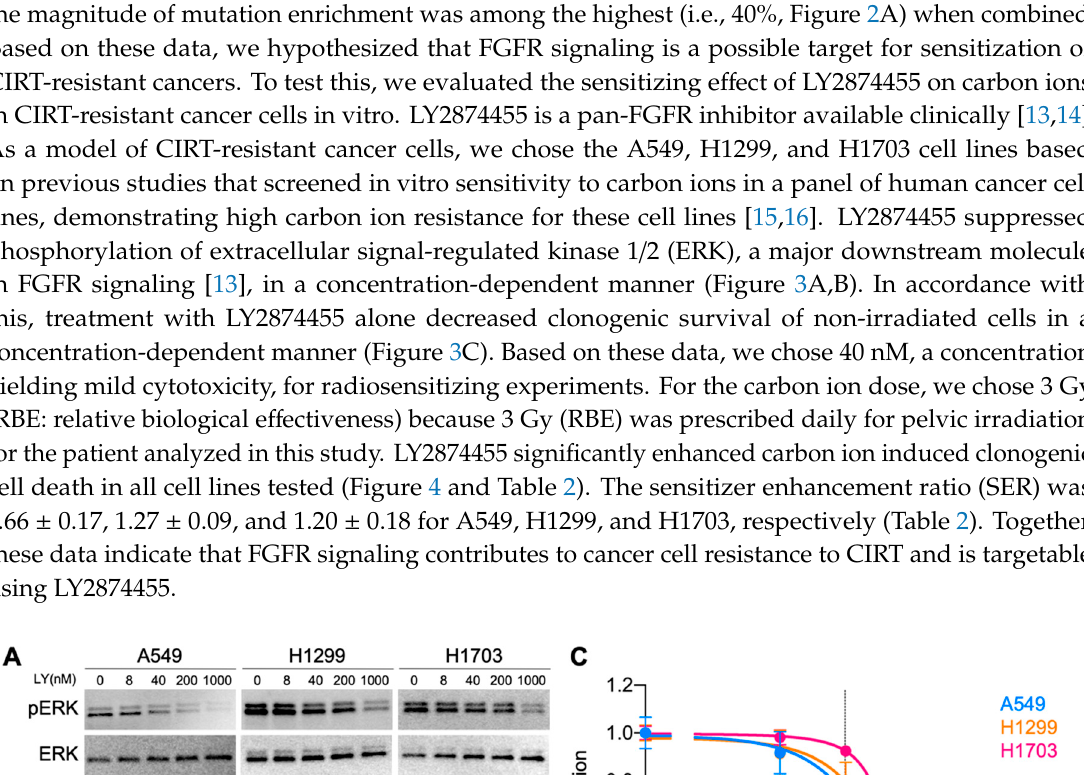
these data indicate that FGFR signaling contributes to cancer cell resistance to CIRT and is targetable